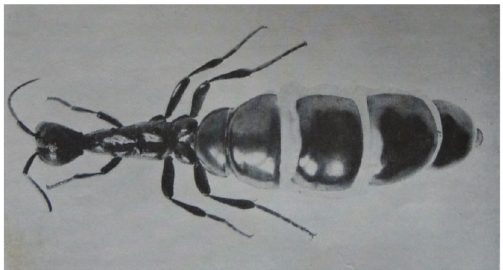
Figure 6: Neivamyrmex pseudops, gravid queen in dorsal view, photographed by Bruch.